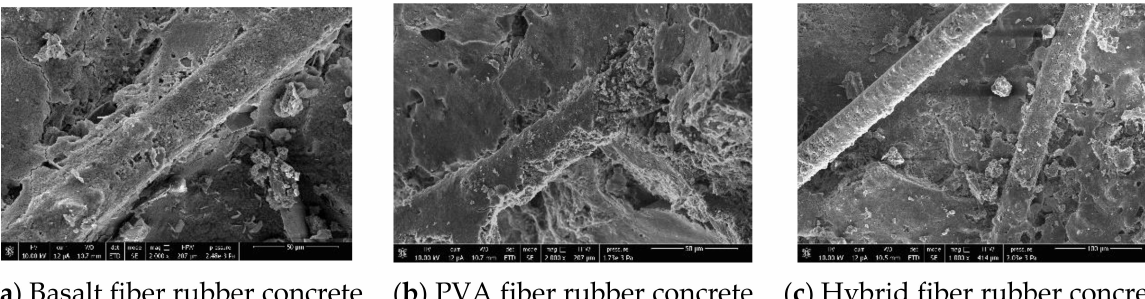
Figure 6. Adhesion between fiber and matrix.